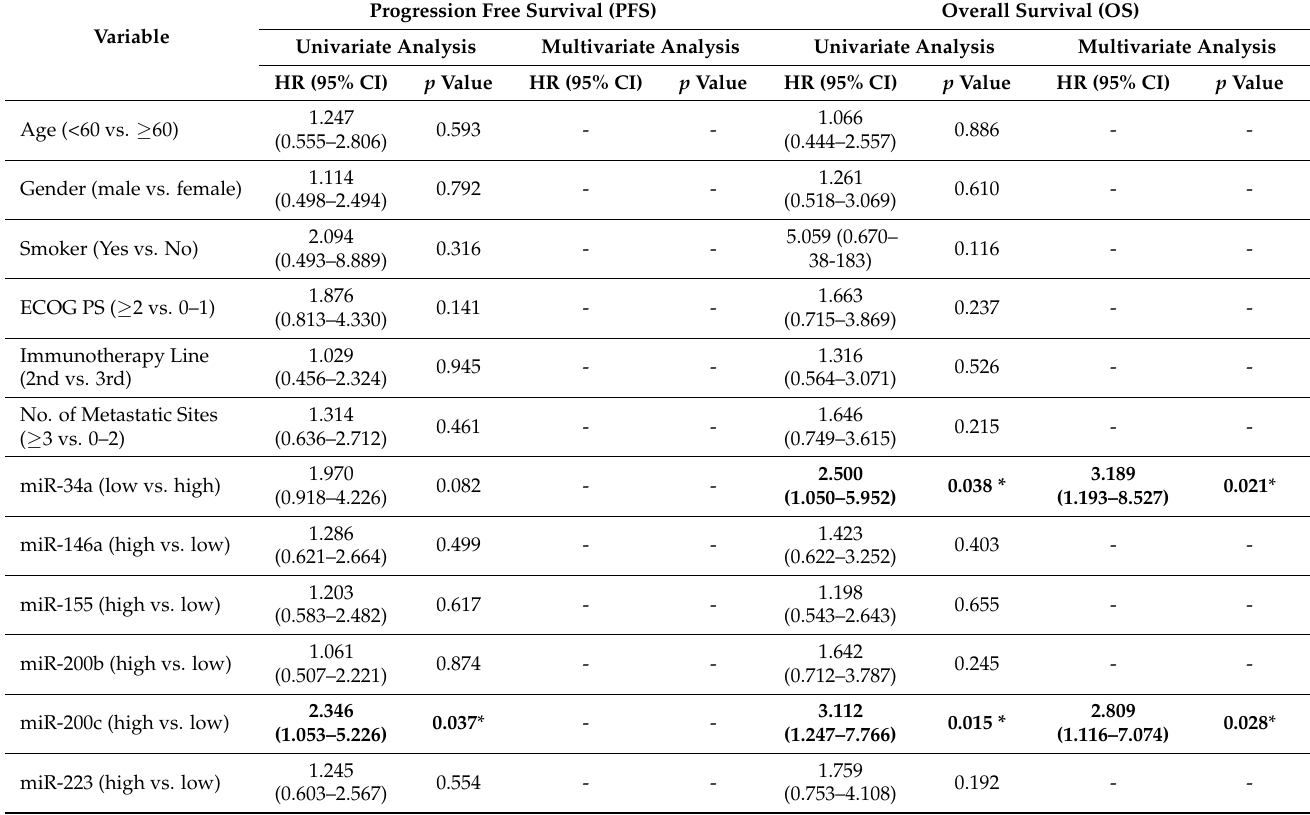
Table 4. Univariate and Multivariate Cox Regression Analysis for Progression Free Survival (PFS) and Overall Survival (OS) in Patients with non-SqCC Subtype (N = 38) Treated with